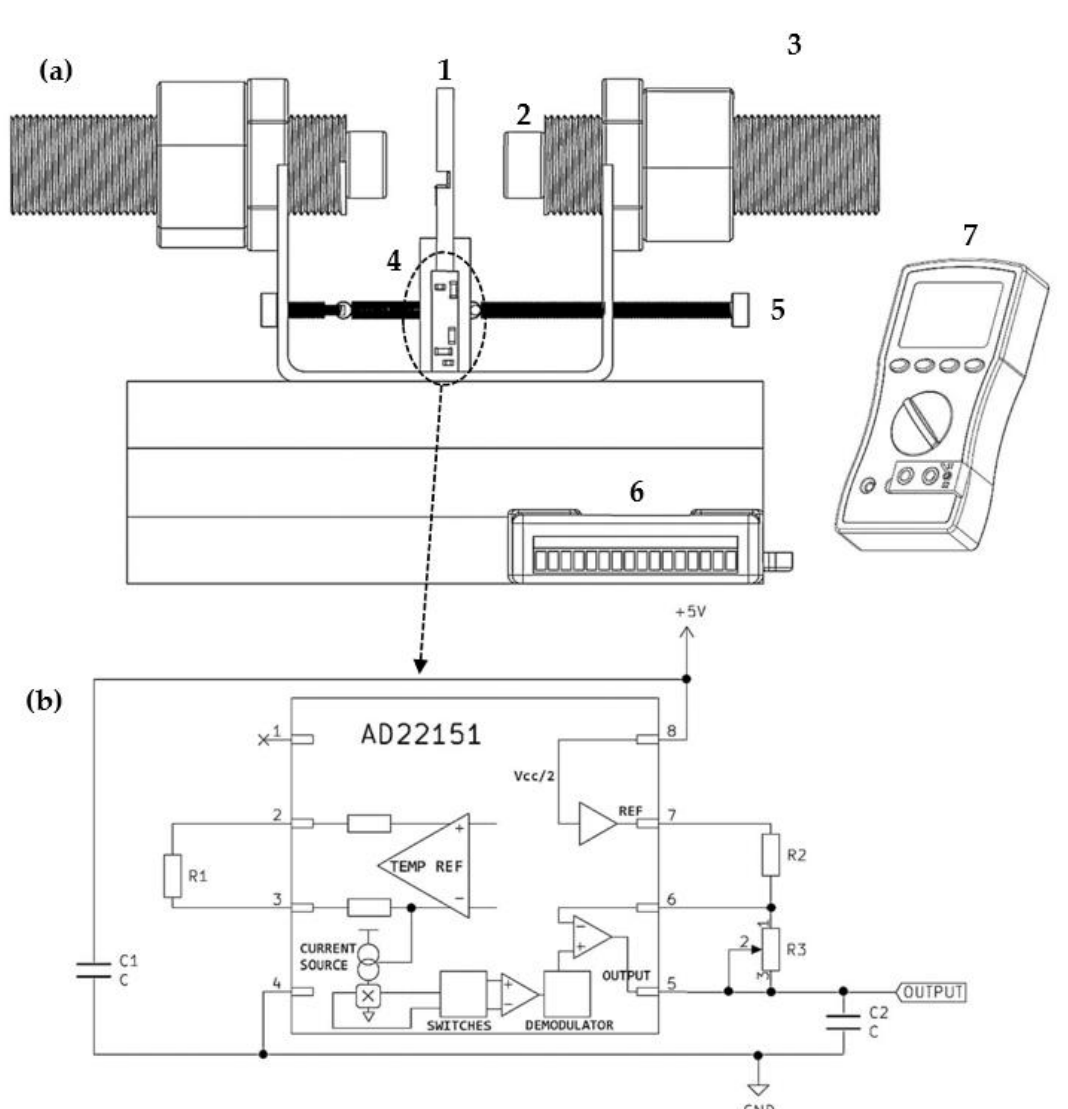
Figure 1. ( a ) Schematic figure of the magnetometer built with all components, two magnets, and an acrylic plate (probe Hall) in the center with two Hall effect sensors assembled on an iron base. The sensors are powered by a source of DC current, and the reading of the output voltage is taken by a multimeter. (1) We used an acrylic plate of 65 × 55 mm with 10.5 mm of thickness, (2) two neodymium magnets of the same configuration containing 12.78 mm thick and 19 mm in diameter, (3) all these are on an iron base containing two screws of the same configuration, (4) a printed circuit board used to operate the sensors plate, (5) an alignment system consisting of a screw and a spring system, (6) an aluminum base, (7) a battery set or a power supply system that can supply the sensors with 5 V DC. ( b ) Circuit board used to use the Hall sensor.